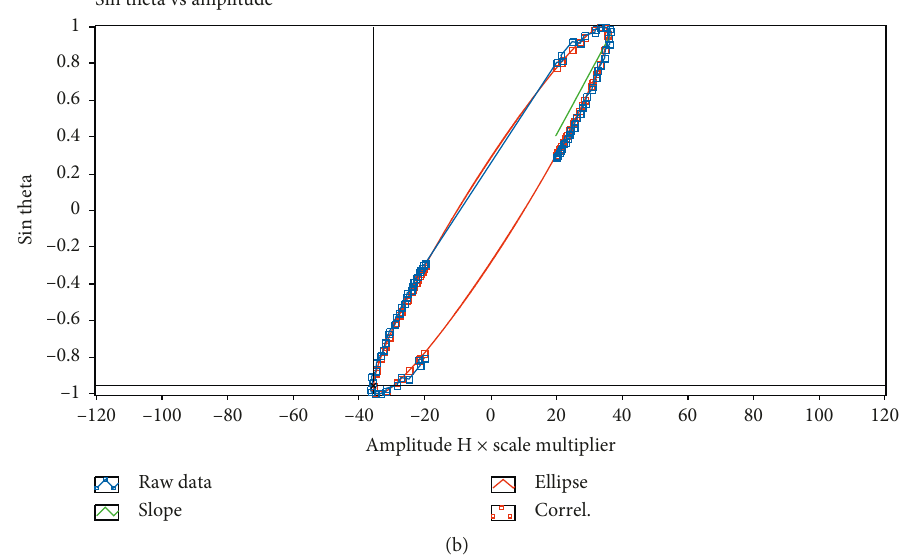
Figure 8: Ellipse area for plate B1: (a) healthy; (b)